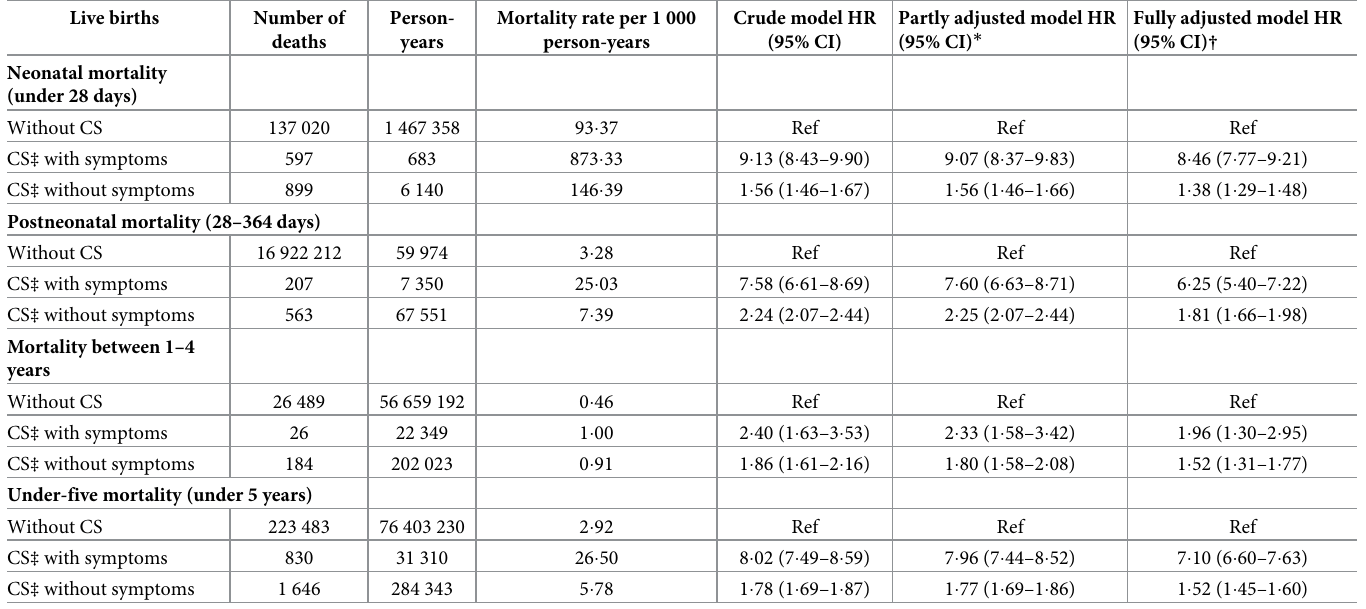
Table 5. Mortality risk by age group and symptoms status among singleton live births in the cohort-linked data, Brazil,